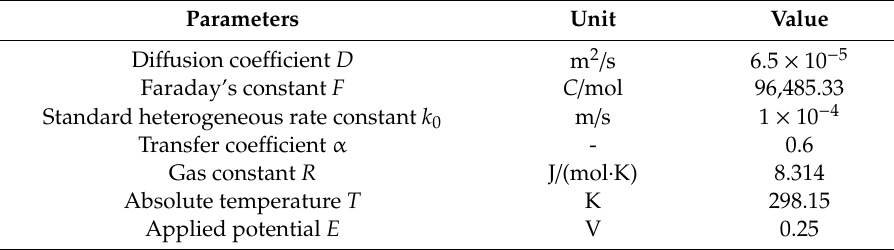
Figure 2. ( a ) The computational domain of the µ EDS; ( b ) The schematic diagram of the meshing method. Table 2. Parameters for the numerical simulation.